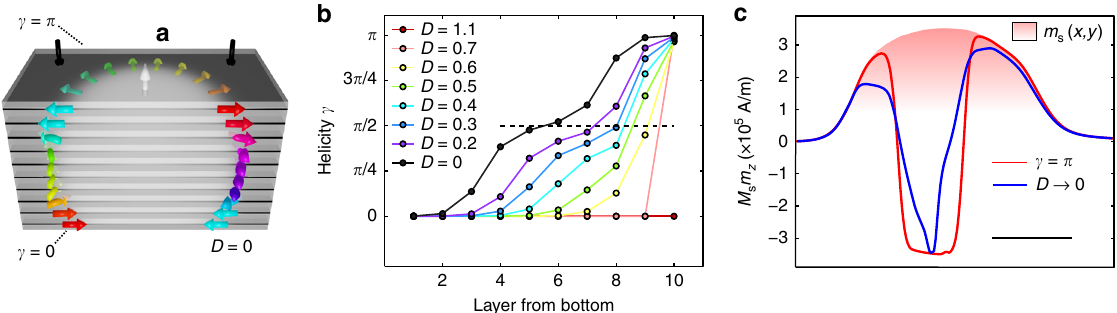
Fig. 5 Néel caps in magnetic multilayers hosting topological spin structures. a Sketch of the magnetic texture obtained via a micromagnetic numerical simulation. The closure domains (i.e. Néel caps 28 ) at the top and bottom of the multilayer reduce the demagnetization energy cost with respect to the purely Bloch case. In the simulation M s = 10 6 A/m, A = 10 pJ/m, magnetic anisotropy fi eld is 0.2 T and D i = 0 (see Supplementary Note 8). The number of layers and separation is representative of the measured sample. The non-uniformity of M s and layer thicknesses is not taken into account for this simulation, which may lead to an underestimation of dipolar effects. b Local helicity for each one of the ten magnetic layers as the DMI value is varied. The DMI is expressed in mJ/m 2 . Skyrmions with γ → π ( γ → 0) are present at the top (bottom) of the stack. c Cut through of the reconstructed m z pro fi les from topologically protected textures that produce a stray fi eld matching the experimental data in Fig. 4c. The red curve corresponds the effective gauge fi xed at γ = π for each layer; the blue curve corresponds to a value of γ = π ( γ = 0) for the top (bottom) three layers and γ = π /2 for the four layers in the middle. This red curve approximates the D i → 0 case depicted in a . The fi lled shaded region represents the spatial variation of the saturation magnetization. The NV depth was again fi xed at 30 nm. The scale bar is 500